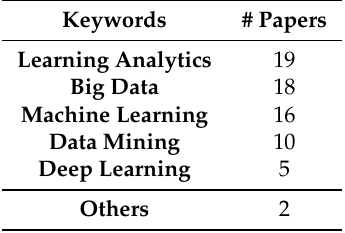
Table 3. Number of papers mentioning relevant keywords for data collection and